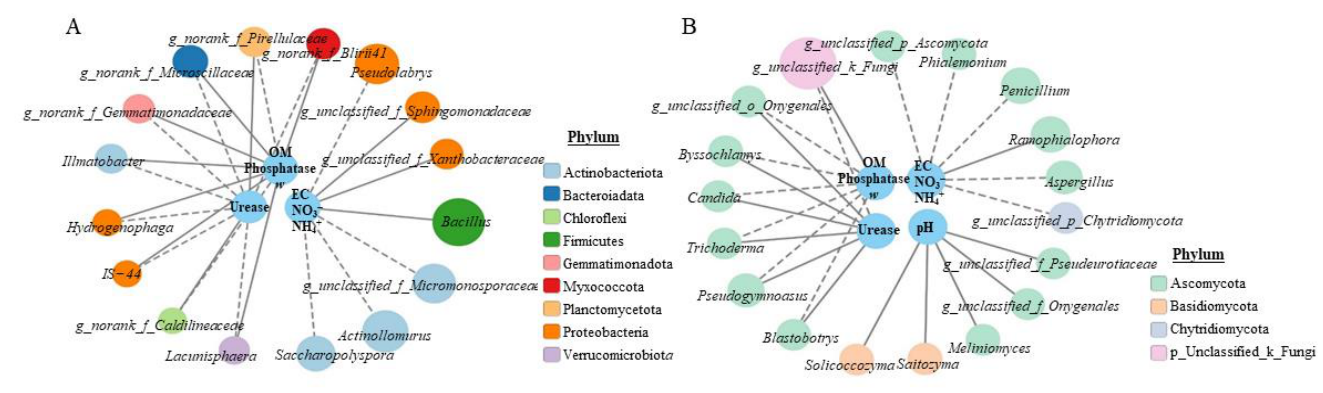
Figure 3. The correlation between environmental parameters and genera for different treatments. ( A ) Network analysis for bacteria; ( B ) network analysis for fungi. The grey solid line indicates a positive correlation, whereas the grey dotted line indicates a negative correlation ( A , B ). The bigger the circle, the higher relative abundance ( A , B ).